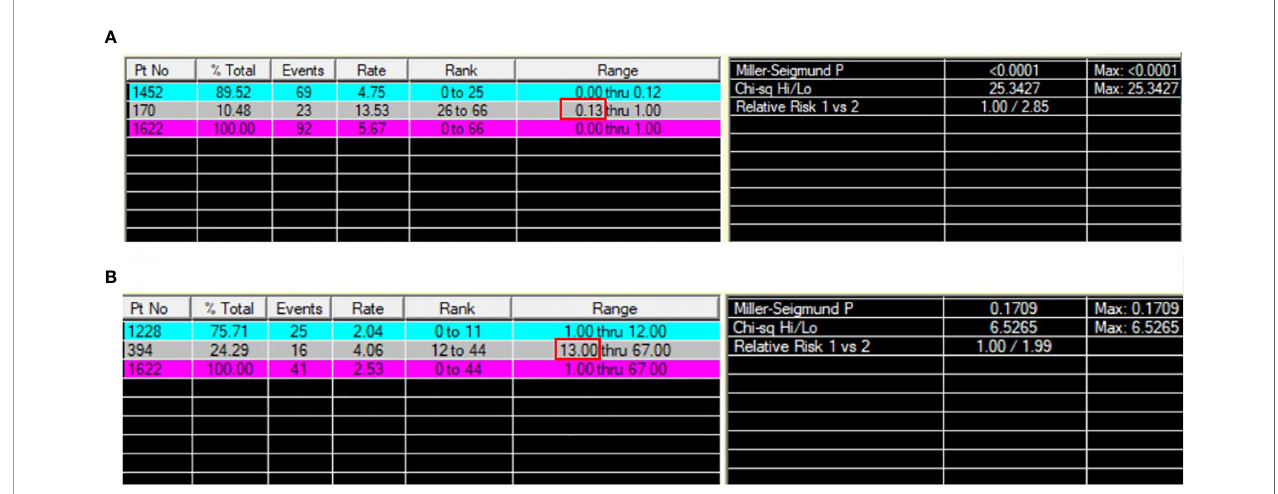
FIGURE 2 | Optimal cut-off value analyses of PLNR (A) and NRN (B) by